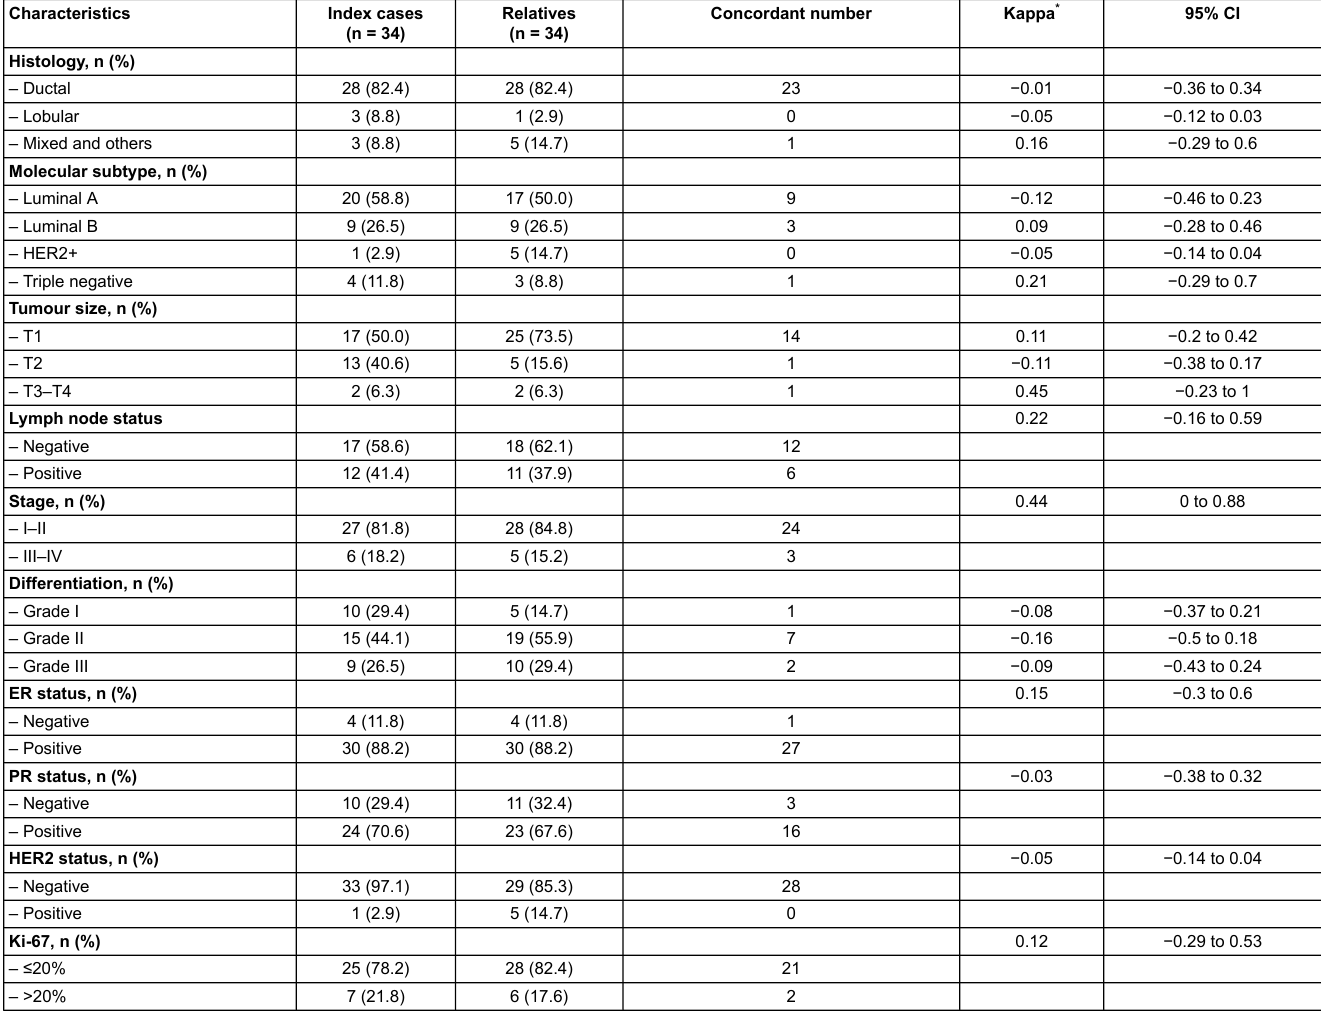
Table 3: Tumour characteristics of breast cancer in sister pairs (data from pathology review). Characteristics